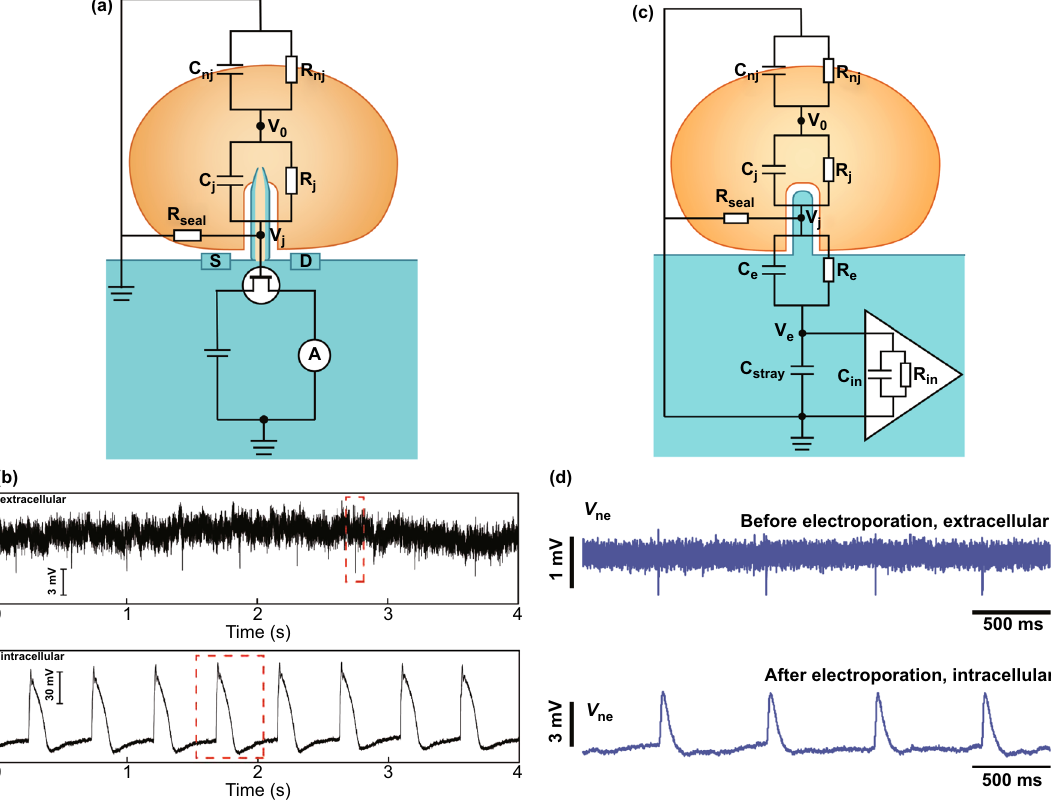
Fig. 4 The equivalent circuit for simulating cell-nanodevice coupling. a Circuit model for describing the active field-effect transistor recording. b Extracellular and intracellular recording by active field-effect transistor. Reproduced with permission from Ref. [87]. Copyright 2010, Ameri- can Association for the Advancement of Science. c Circuit model for describing the passive nanoelectrode array recording. d Extracellular and intracellular recording by passive nanoelectrode array. Reproduced with permission from Ref. [92]. Copyright 2017,